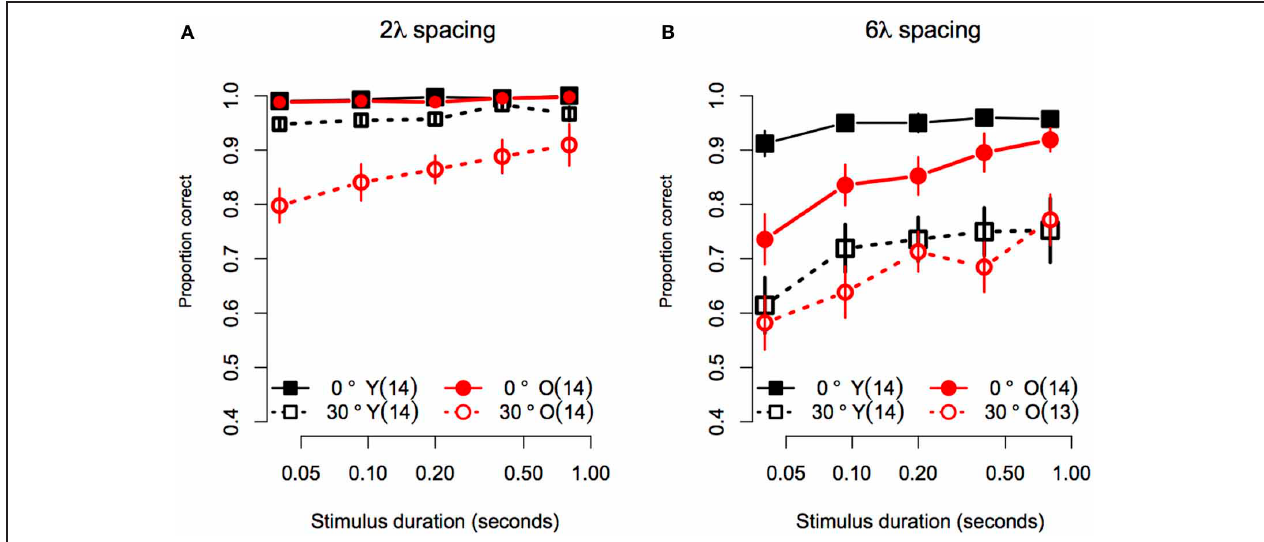
FIGURE 5 | Experiment 2 results: Contour discrimination accuracy is shown as a function of stimulus duration for (A) contours with small contour element spacing and (B) contour with large contour element